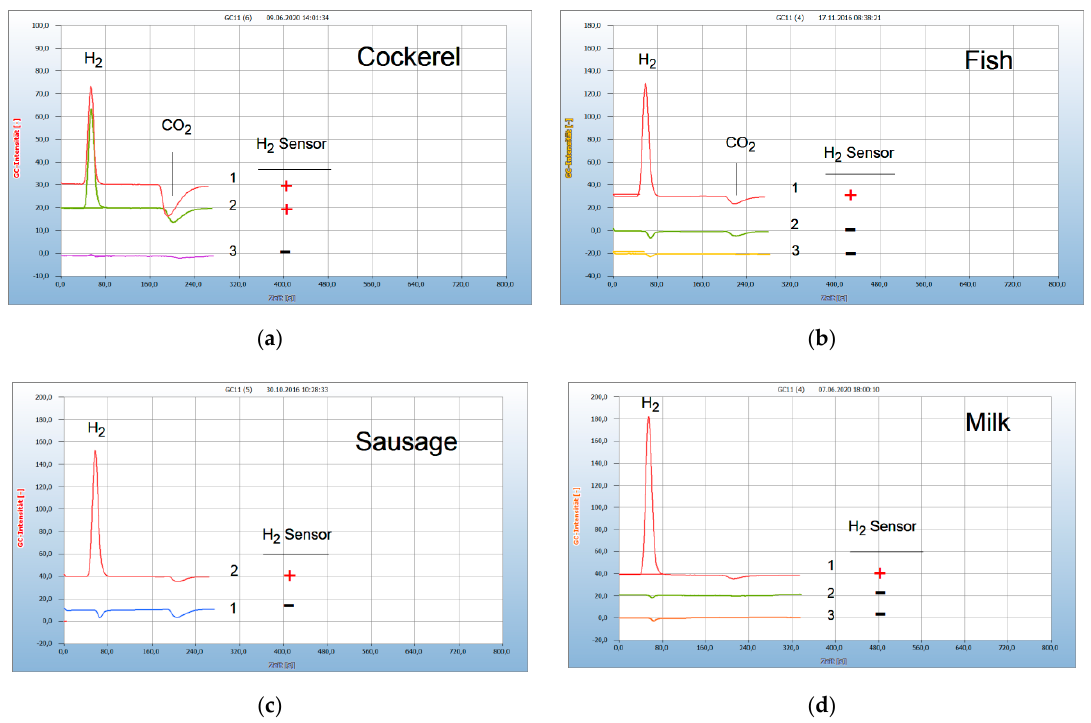
Figure 3. Bacterial contamination in food, analyzed by HS-GC and the H 2 sensor approach. Gas chromatography: column Silicagel, carrier gas ambient air, 6 mL headspace vials, 2.5 mL culture broth. H 2 emission ( + ), no H 2 emission ( − ). Blank: cotton bud in culture broth. ( a ) 1 = meat from a cockerel ( + ), 2 = added penicillin ( + ), 3 = added oil of cloves. ( b ) 1 = meat from salmon from supermarket, ( + ), 2 = trout freshly caught from a clear river ( − ), 3 = blank ( − ). ( c ) 1 = liver-sausage, fresh ( − ), 2 = after 8 days in a refrigerator ( + ). ( d ) 1 = raw milk, 1 mL in 2.5 mL culture broth ( + ), 2 = pasteurized milk, 1 mL in 2.5 mL culture broth ( − ), 3 = blank ( − ).